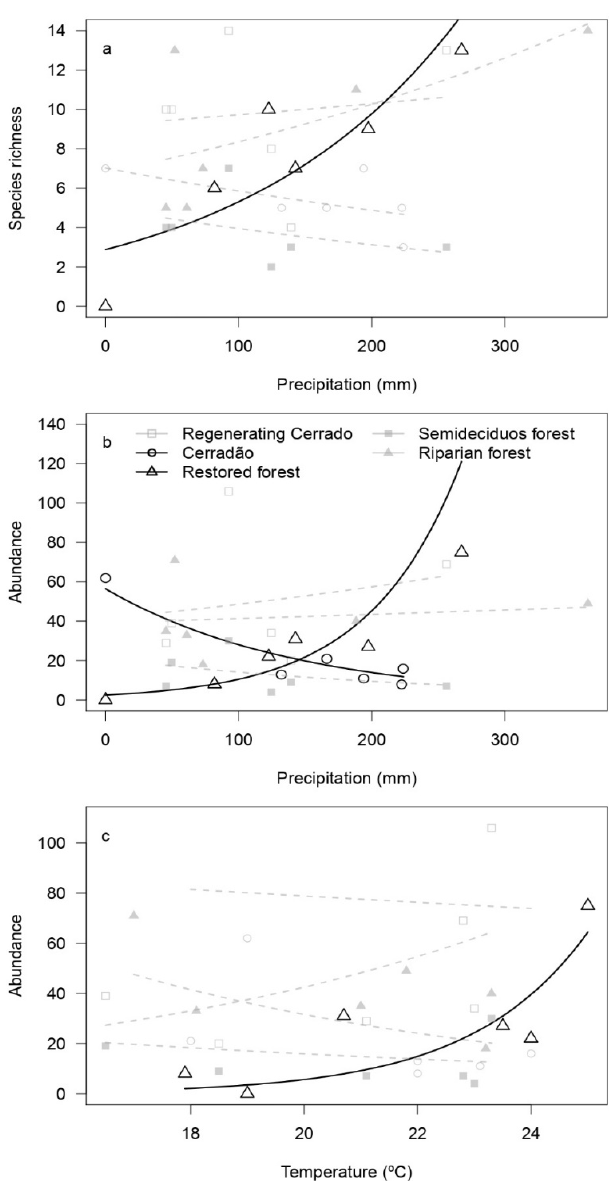
Fig 6 . Effects of monthly precipitation on a) species richness and b) abundance, and effect of, c) mean temperature on the abundance of social wasp in five vegetation types in southern Brazil. Significant relationships are shown in black color, while no significant relationship are in grey